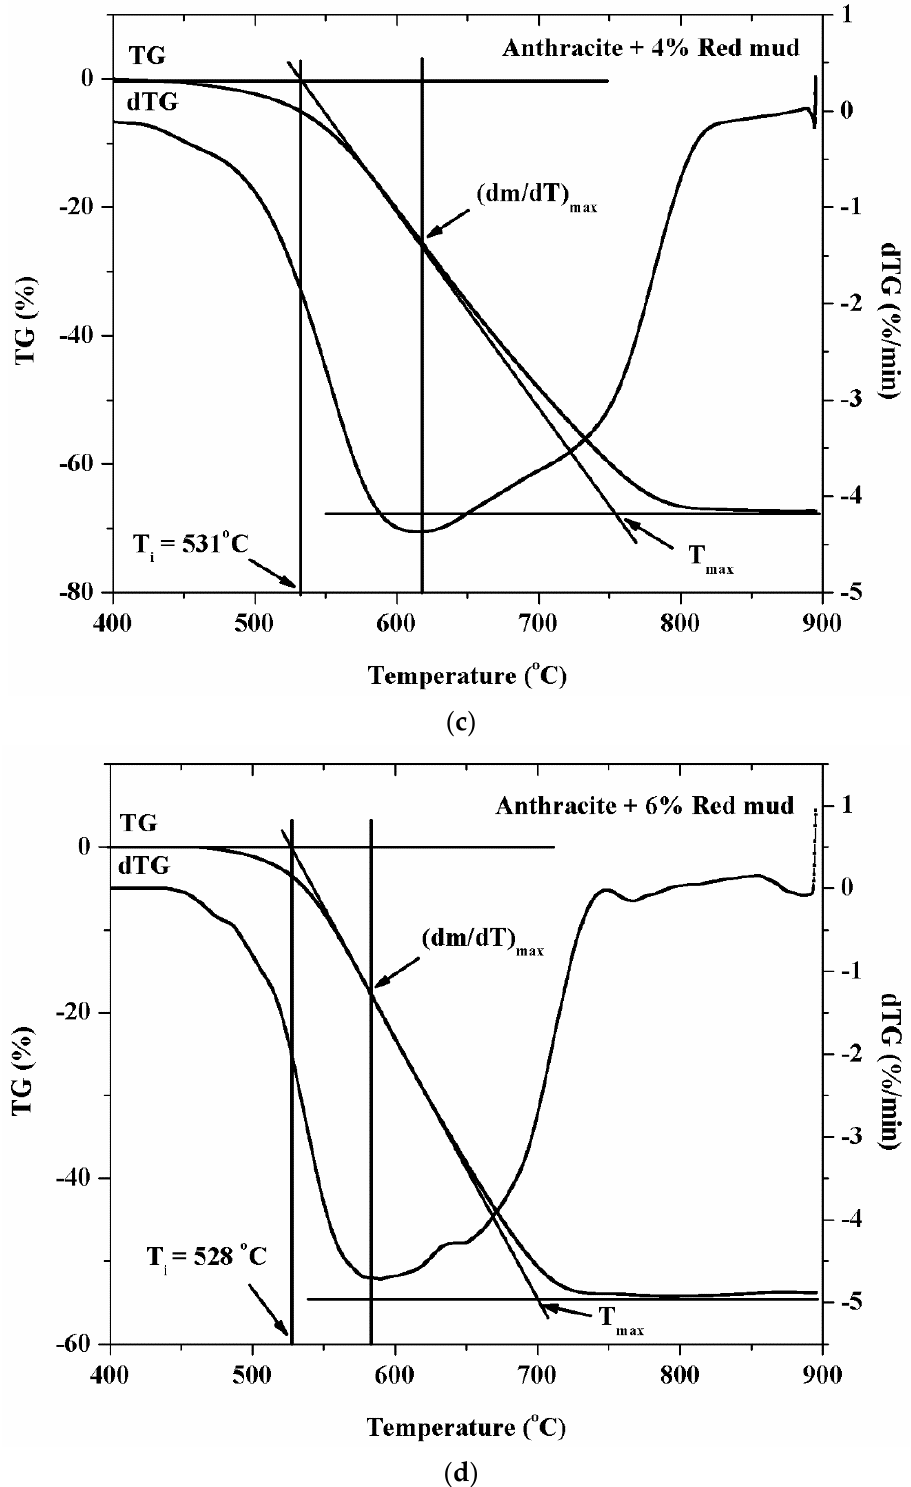
Figure 4. TG-DTG curve of anthracite combined with red mud: ( a ) Raw anthracite; ( b ) Anthracite + 2% red mud; ( c ) Anthracite + 4% red mud; ( d ) Anthracite + 6% red mud. Table 3. Comparison of the effects of industrial wastes on the ignition temperature and burnout efficiency of Vietnamese anthracite and Jincheng anthracite.